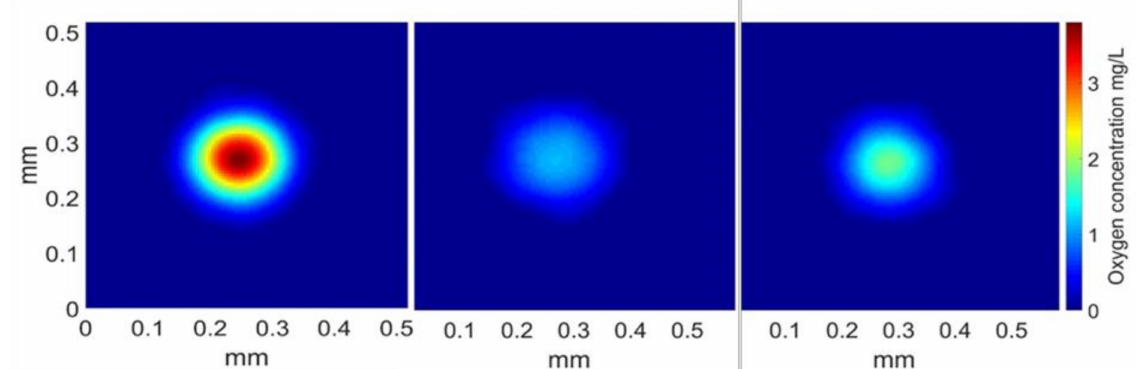
Figure 6. Representation of the oxygen concentration in a plane perpendicular to the bubble wake, 182 ms after the bubble’s passage. Medium from left to right: water, water + Triton X-100, and water + Triton X-100 +